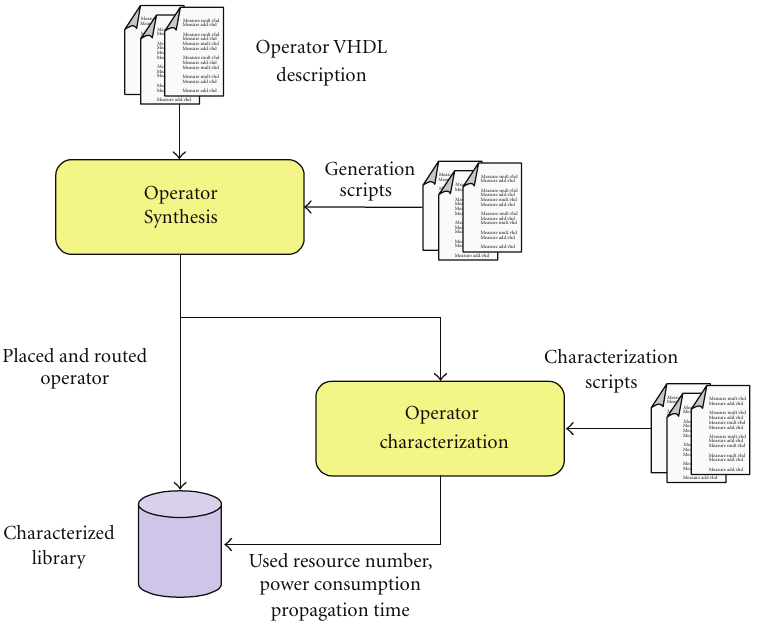
Figure 5: Operator synthesis and characterization